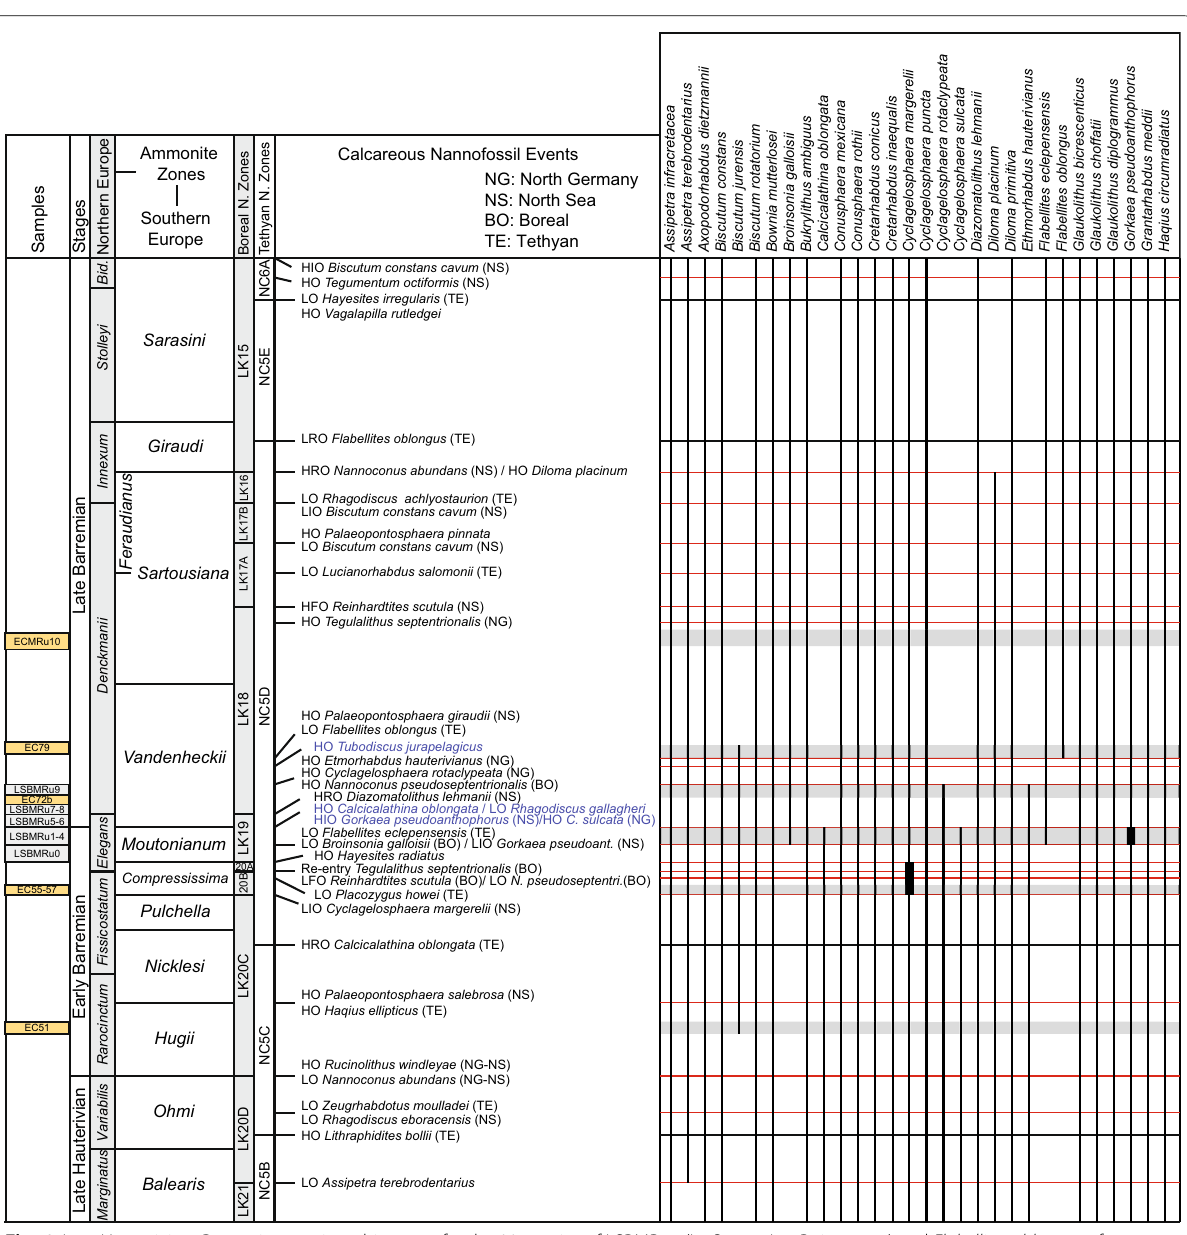
Fig. 6 Late Hauterivian–Barremian stratigraphic range for the 90 species of LSBMRu1 (La Sarraz–Les Buis quarry) and Flabellites oblongus of EC79‑ECMRu10 (Eclépens